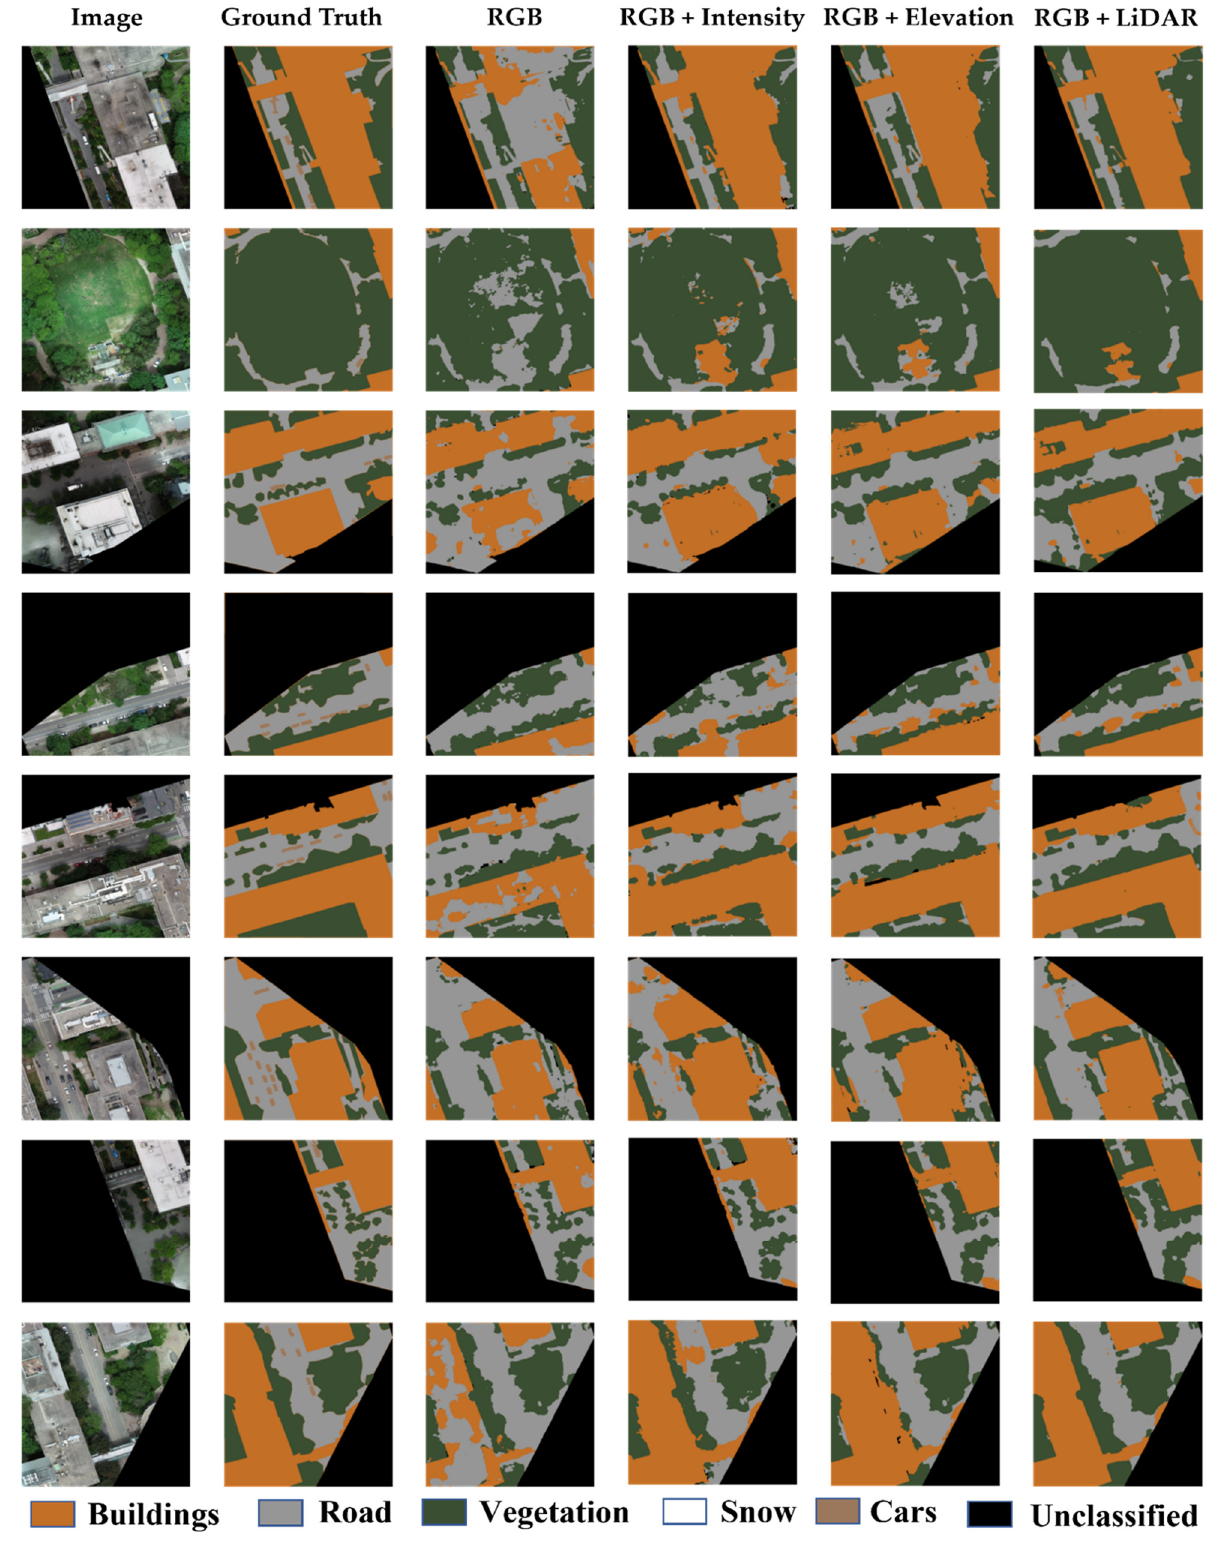
Figure 24. Comparison of the DCNN prediction results of the second dataset.